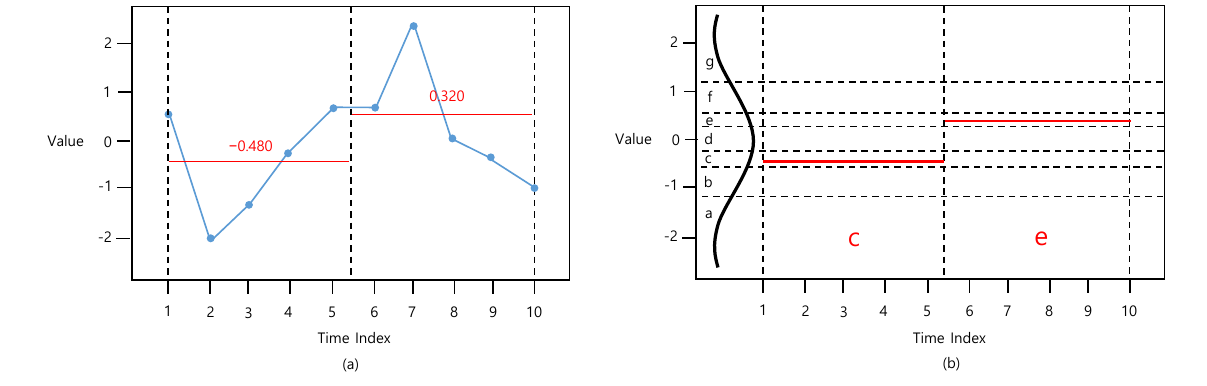
Figure 1. Procedure of ( a ) PAA ( t_size = 5) and ( b ) SAX ( n_bins = 7). Here, a constant N is called the time segment size ( t_size ), which is used as the main S PAA hyperparameter.